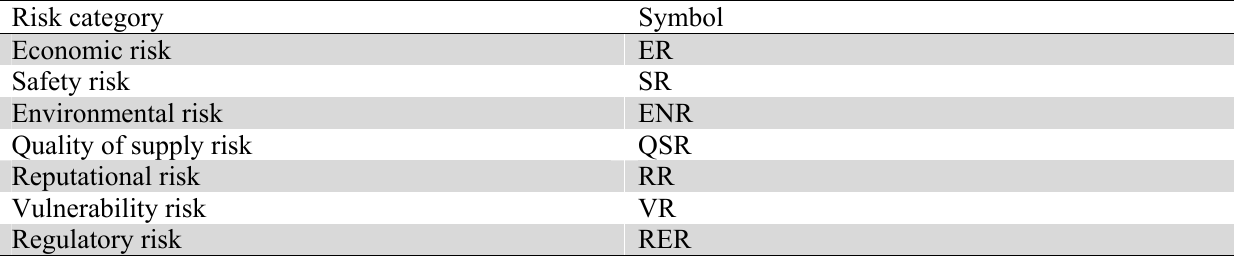
List of the risks identified